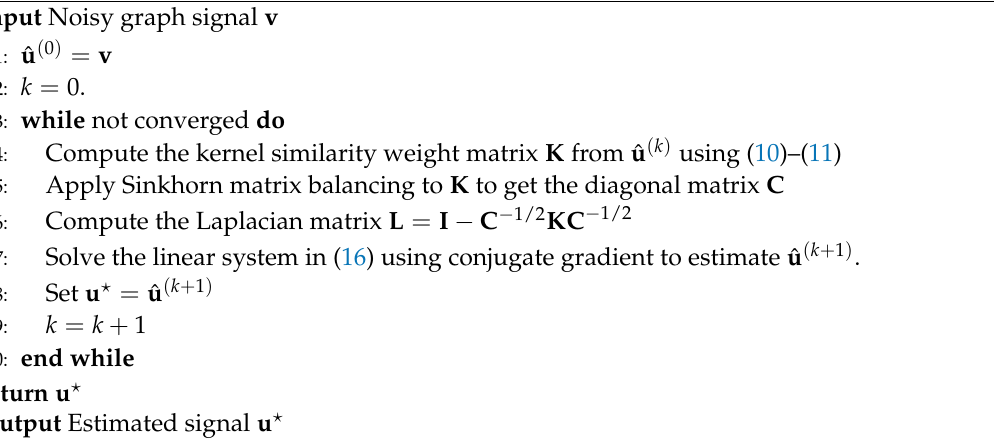
Algorithm 1 Feature-Preserving Mesh